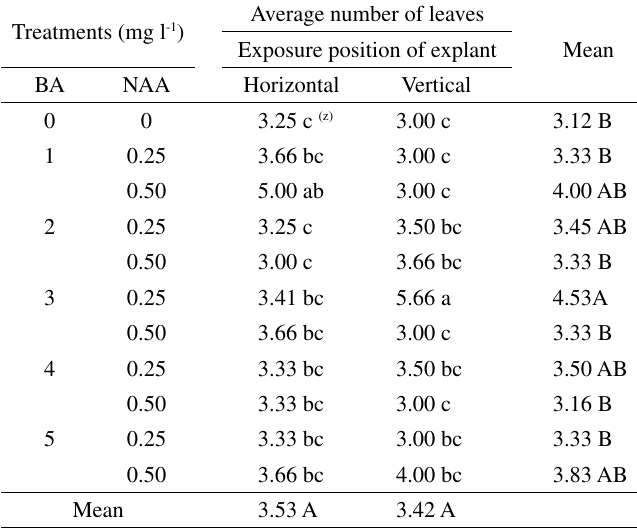
Table 9 - The interaction effect of different concentrations of BA and NAA, and exposure position of explants on the average leaf number in ‘Variegated’ Average number of leaves Treatments (mg l -1 ) MeanExposure position of explant BA NAA Horizontal Vertical